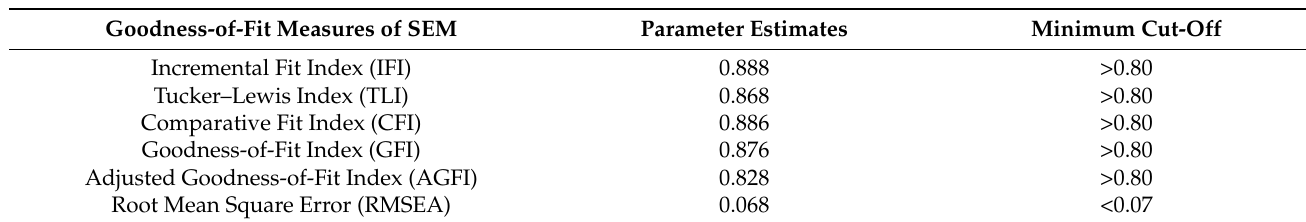
Table 4. Model fit.